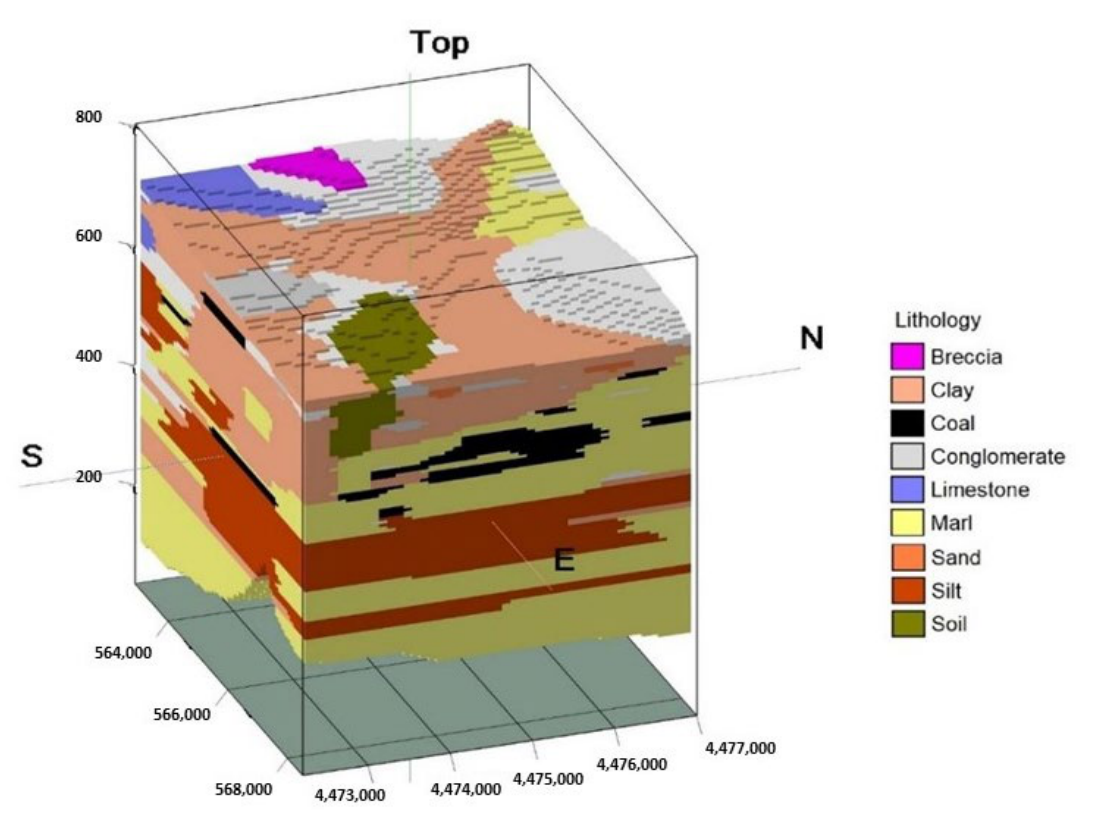
Figure 9. Interpolation of the 3D block model (Vertical Exaggeration = 8x, 1100/260 compass bearing/angle from the horizon). The development of the 3-D model of the study area was created with RockWorks version 17 [41]. Vertical axis represent a.s.l values.